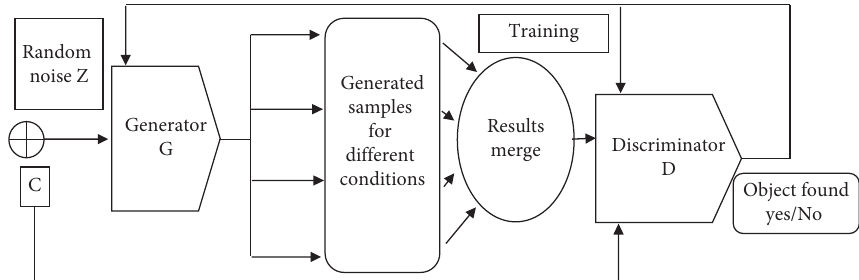
Figure 4: Conditional GAN model architecture for object